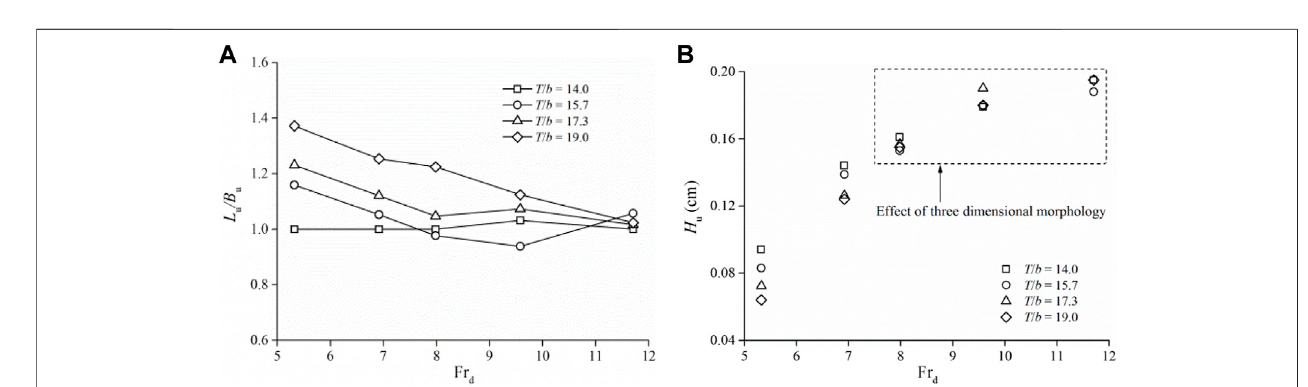
FIGURE 9 | Effects of jet impact on scour morphology: (A) planar features; (B) three scale effects.